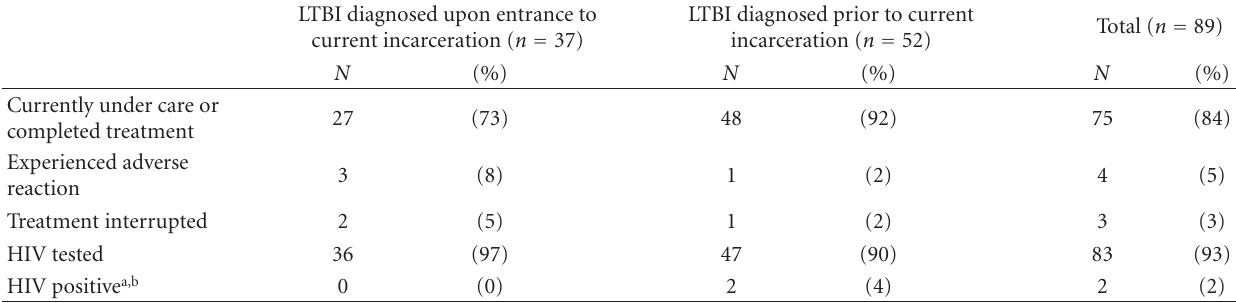
Table 5: Treatment outcomes for inmates at PCI diagnosed with LTBI ( n =